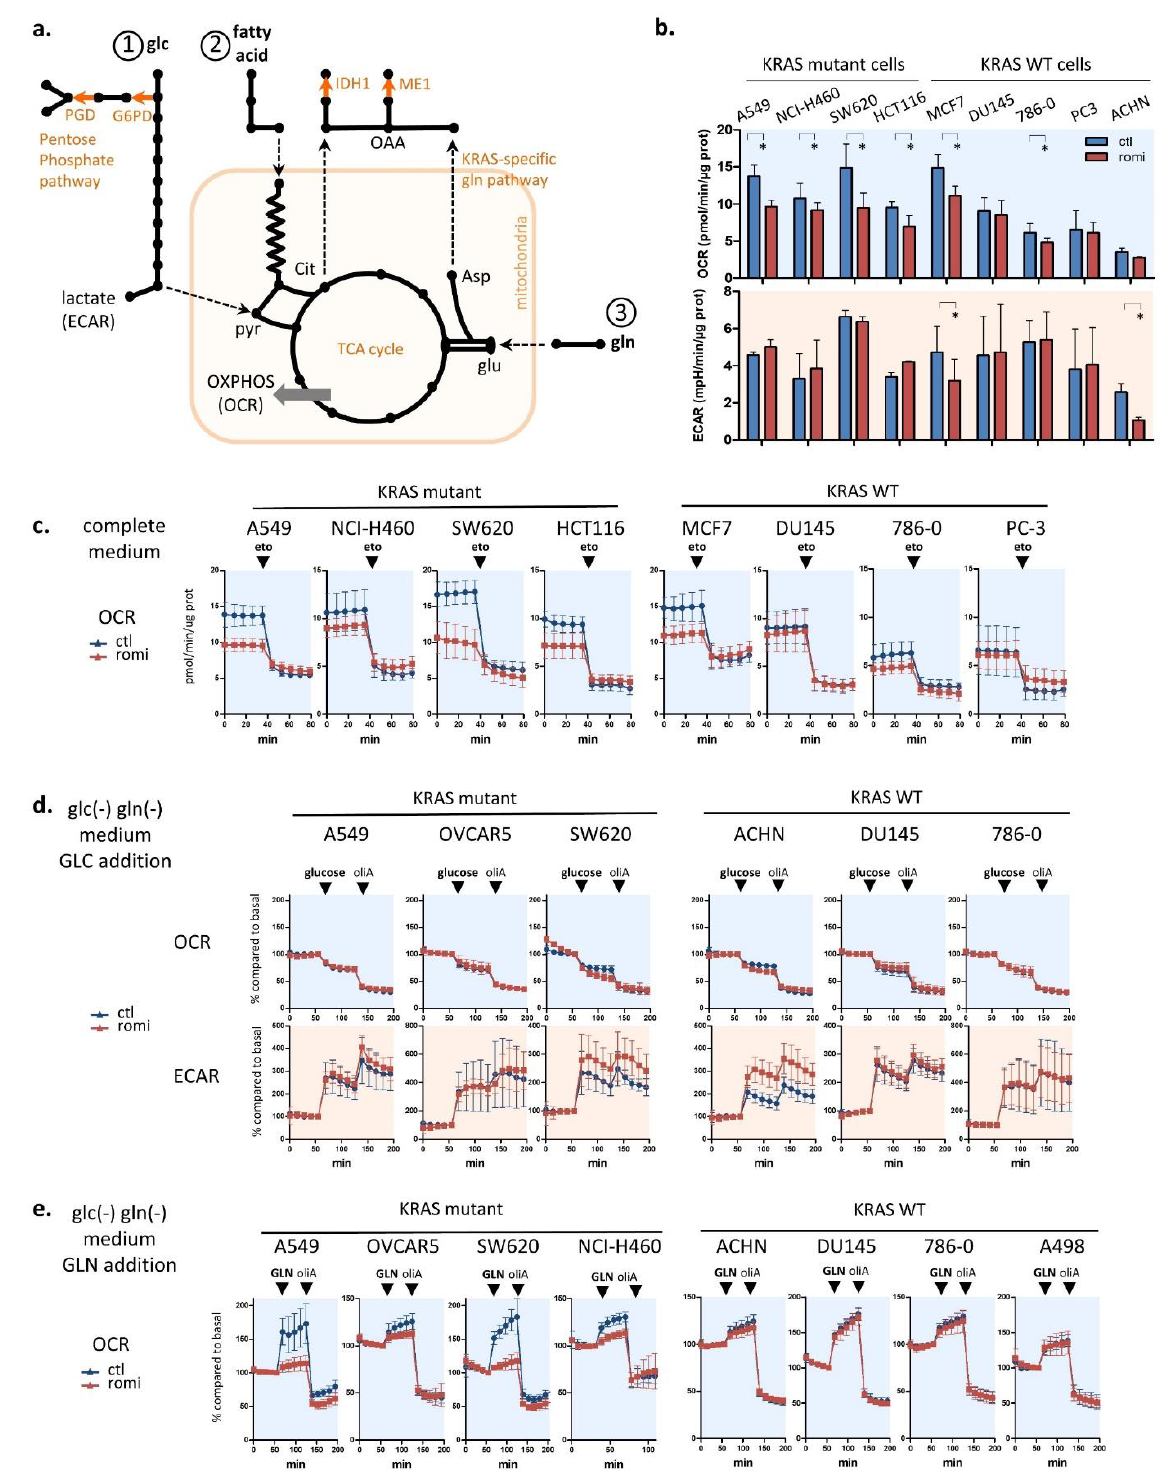
Figure 3 . Romidepsin affects two TCA-fueling pathways: fatty acid beta-oxidation and glutaminol- ysis. ( a ) Schematic view of cytoplasmic ROS scavenging through NADPH producing-metabolic en- zymes and their link with the three main TCA cycle fueling pathways (1/glycolysis, 2/beta-oxidation, 3/glutaminolysis). Cytoplasmic NADPH producing enzymes are downstream of glutaminolysis in KRAS-mutant cells (ME1), downstream of TCA cycle through citrate production (IDH1), or downstream of the first step of glycolysis (PGD and G6PD in pentose phosphate pathway). ( b ) Basal OXPHOS and glycolysis were evaluated by measuring oxygen consumption rate (OCR) and extra- cellular acidification rate (ECAR) using a Seahorse XF96 in four KRAS-mutant and five KRAS-WT